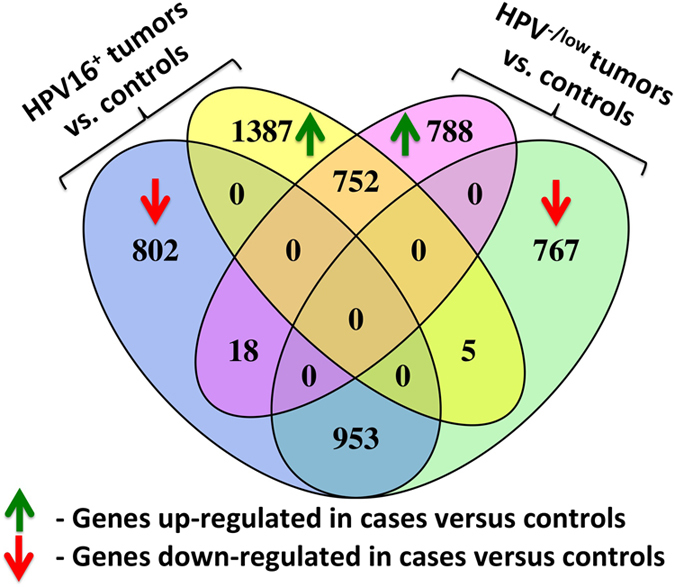
Venn diagram of differentially expressed genes in tumours versus control samples. Blue and yellow ovals show the numbers of down- and upregulated genes in 54 HPV16+ tumours versus 24 controls, correspondingly. Pink and green ovals show the numbers of down- and upregulated genes in 341 HPV−/low tumours versus 24 controls. Controls include three low HPV33 expressing samples and one low HPV16 expressing sample (<200 reads). The majority of differentially expressed genes between cases and controls were specific to the HPV16+ or HPV−/low tumours. Only about a third of the genes were significantly up- or downregulated in both HPV16+ and HPV−/low tumours compared with controls.